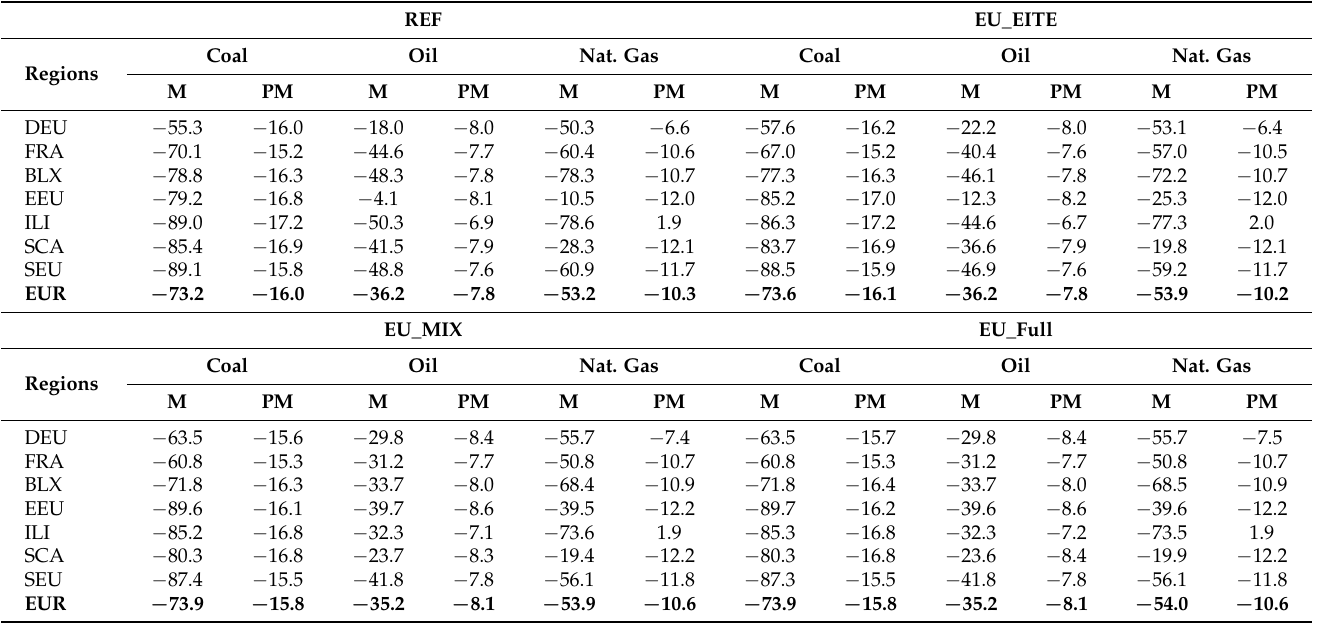
Table 10. Import quantity (M) and import price (PM) of different fuels for different policy scenarios under the NDC-1.5C target using the IEO